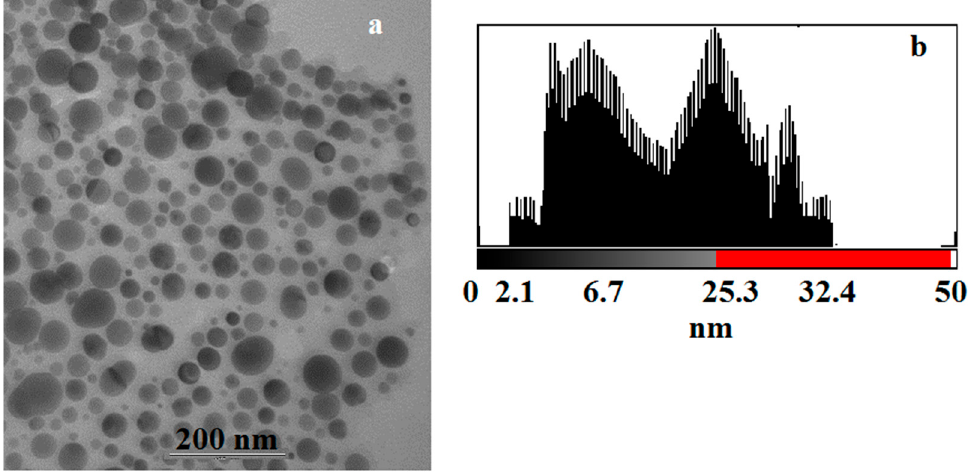
Figure 11. ( a ) TEM image of the silver maleate thermolysis product; ( b ) a histogram illustrating particle size distribution.